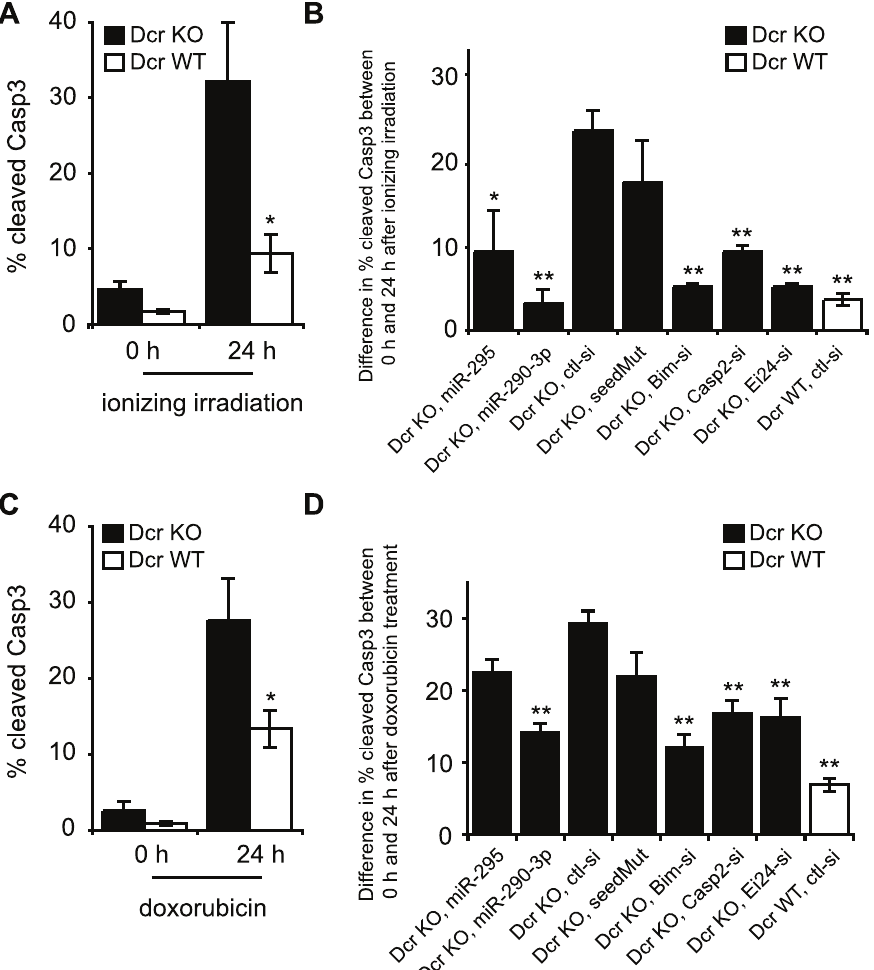
Figure 4. Downregulation of Casp2 and Ei24 partially rescues the increased apoptotic rate of Dcr KO cells following genotoxic stress. A. The percentage of cells expressing cleaved Caspase 3 (Casp3) in Dcr WT and Dcr KO ES cells after exposure to 5-Gy radiation (0 and 24 hours after radiation treatment). Cleaved Casp3 was assayed by flow cytometry, and was used to estimate apoptotic response. Apoptosis rate of Dcr KO cells is shown in black bars, and that of WT cells is shown in white bars. B. Dcr KO cells were treated with 5-Gy radiation 24 hours after transfection of 50 nM miR-295, miR-290-3p, Bim siRNA, Casp2 siRNA or Ei24 siRNA. Casp3 activity was assayed 0 and 24 h after the treatment, and the difference in apoptosis rate is shown. Transfection of seed mutants and control siRNAs into Dcr KO cells, and transfection of control siRNAs into WT cells served as controls. C,D. A similar series of experiments was performed in Dcr WT and Dcr KO cells using 100 nM doxorubicin. n $ 3 for all experiments. Results are shown as mean 6 S.E.M. P-values were obtained by Mann-Whitney tests, * denotes p # 0.05, and ** denotes p #